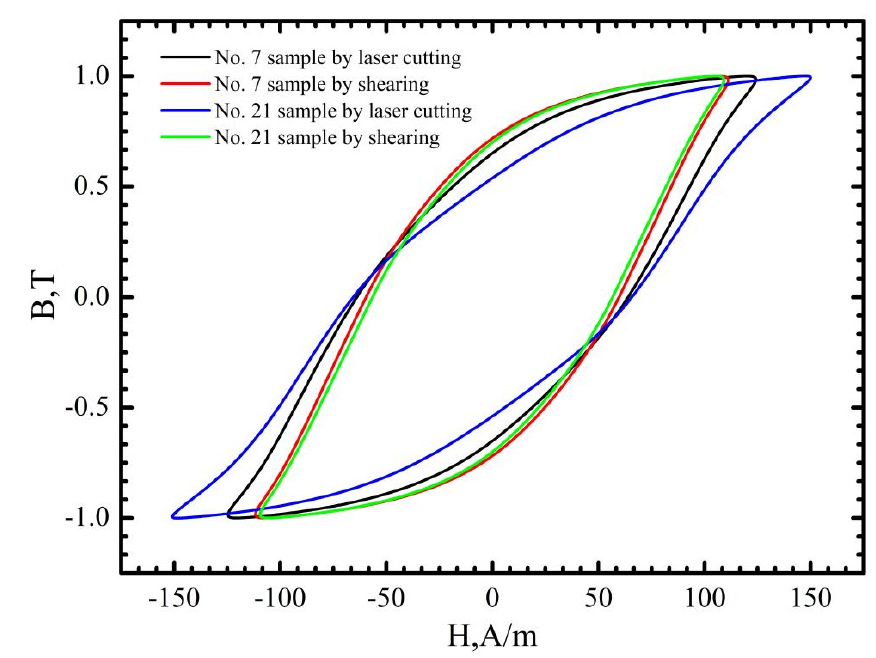
Figure 8. Hysteresis curves at the magnetic induction intensity of 1.0 T of the No. 7 and No. 21 samples processed using laser cutting and mechanic shearing, respectively.